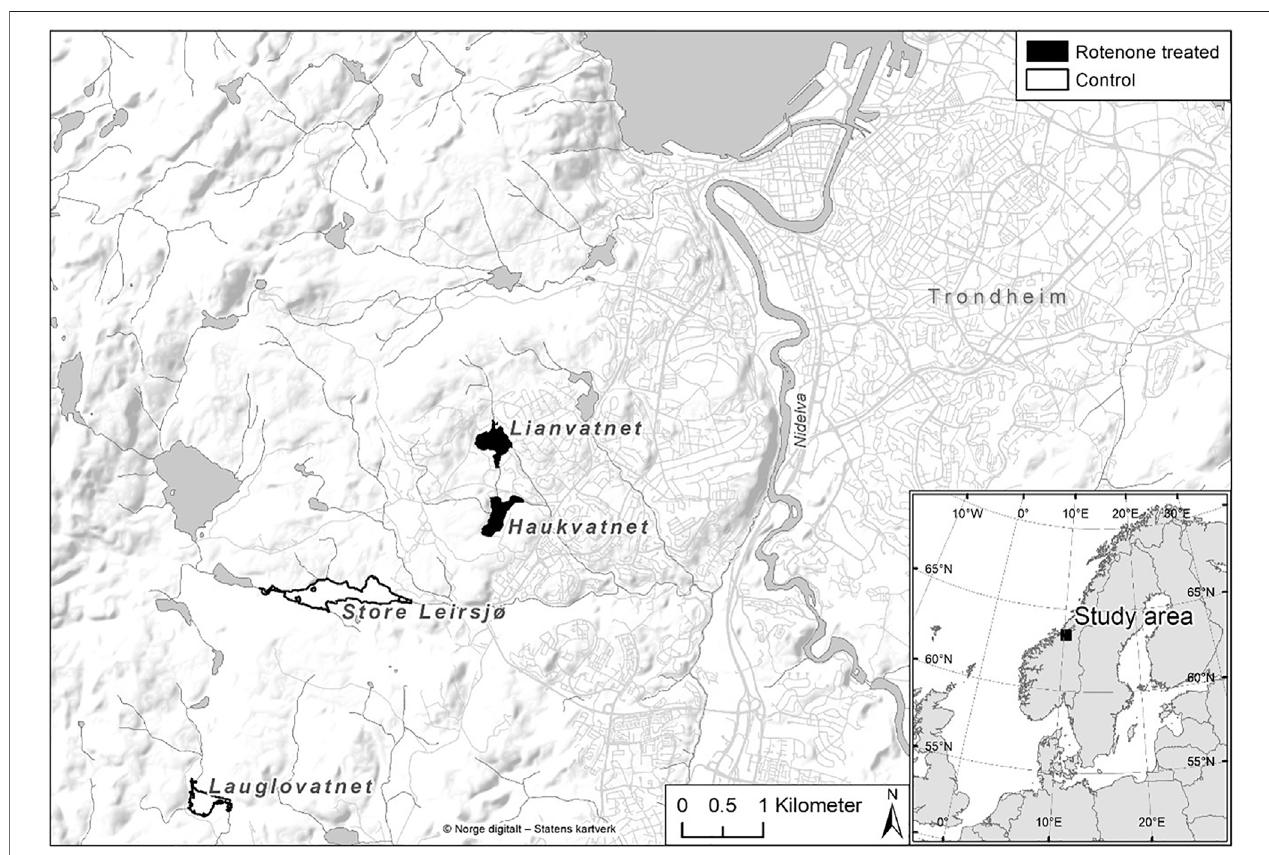
FIGURE 1 | Overview of the Bymarka area in Central Norway with the rotenone treated and control lakes.